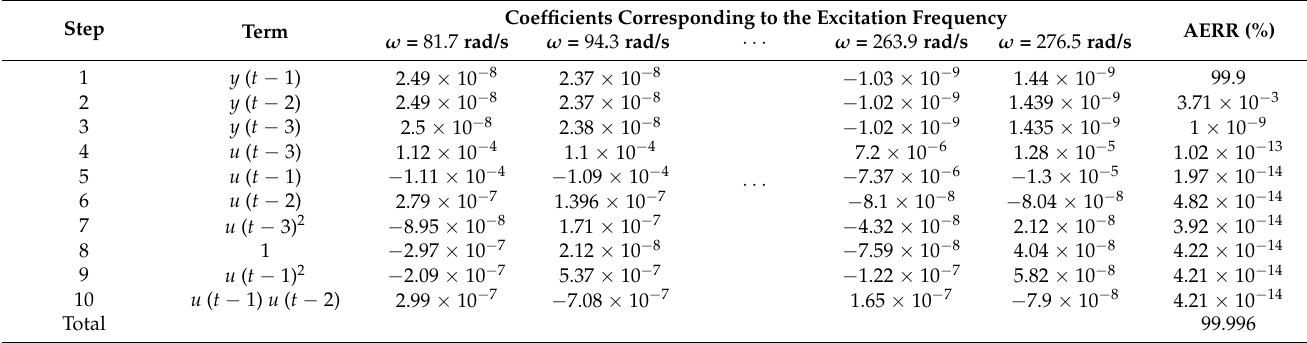
Table 3. The modeling results of the rotor-bearing system in Figure 1.